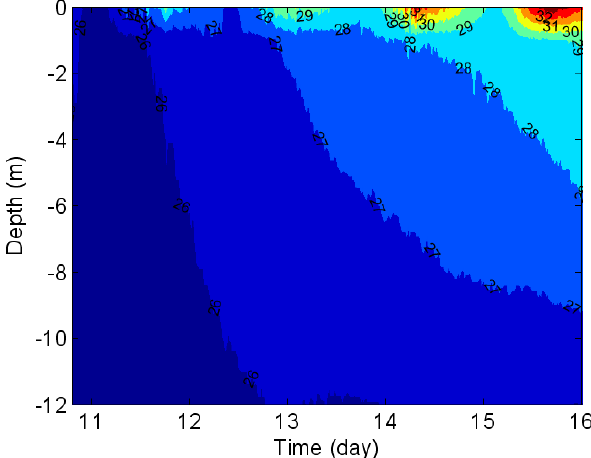
Figure 11: Temperature contours from the thermistor-chain data measured at the river- reservoir transition zone (January) (Station 06). Fig. 11. Temperature contours from the thermistor-chain data mea- sured at the river-reservoir transition zone (January) (Station